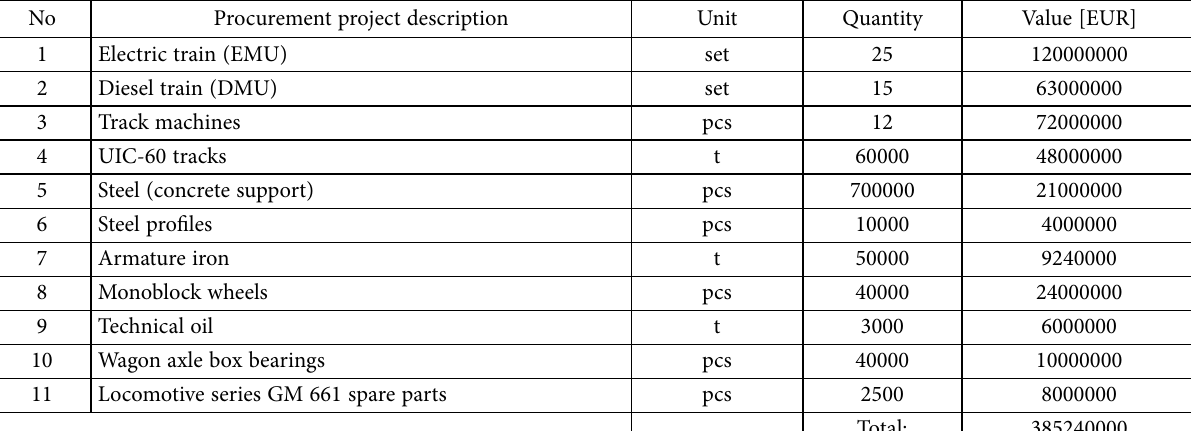
Table 4. Procurement projects candidates for the